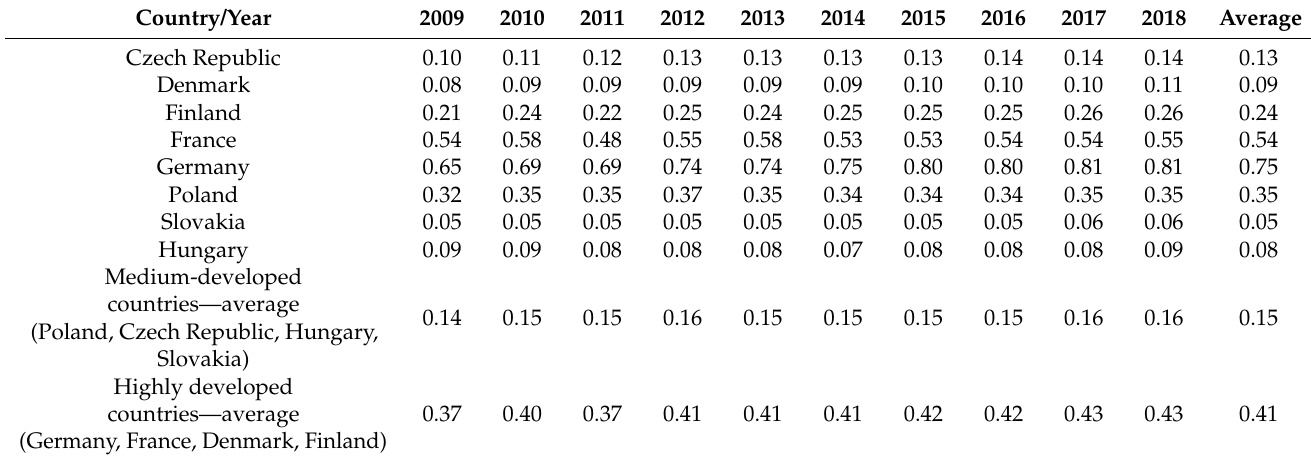
Table 4. Renewable energy consumption per GDP per capita in USD in the surveyed EU countries (in TOE).